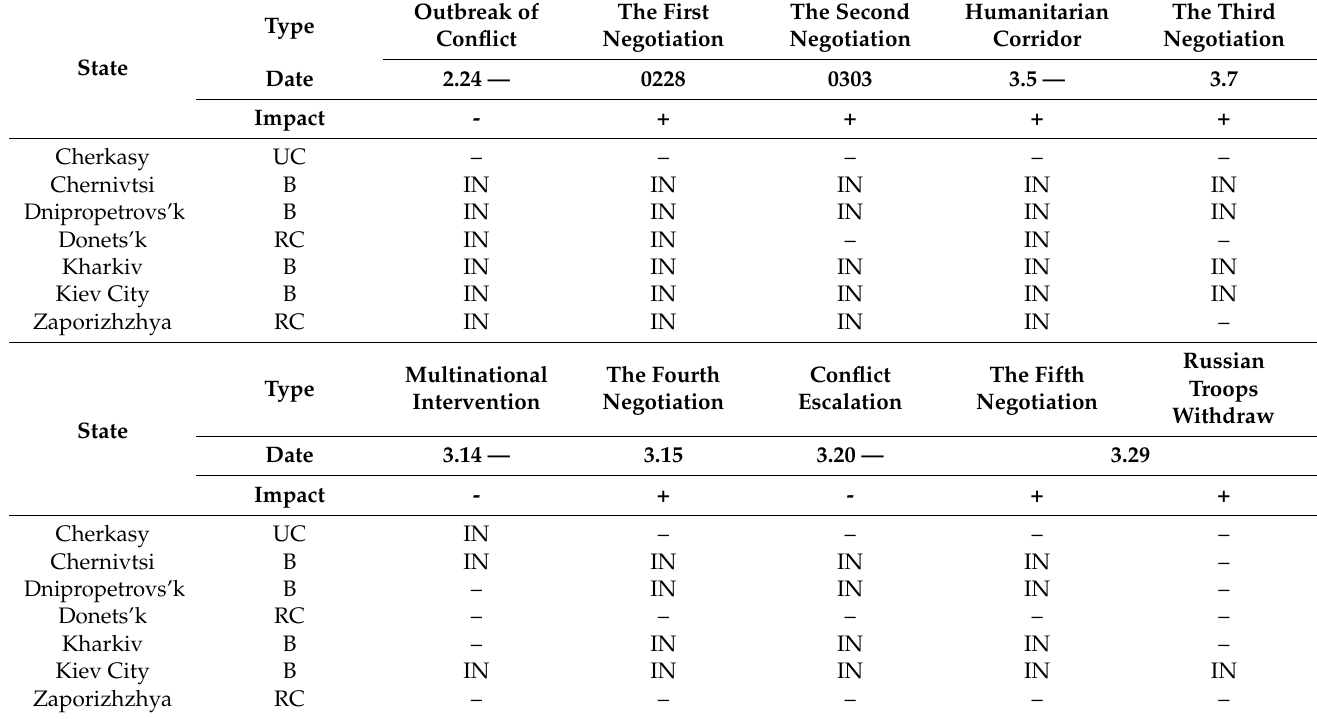
Table 1. Ukrainian cities in military conflict situations. There are three types of cities analyzed here, namely cities in the RC (Russian-controlled area), cities in the UC (Ukrainian-controlled area), and cities in the B (belligerence/conflict area). The plus sign indicates whether a specific event has promoted night-time light restoration, and a minus sign indicates no light restoration prompted by an